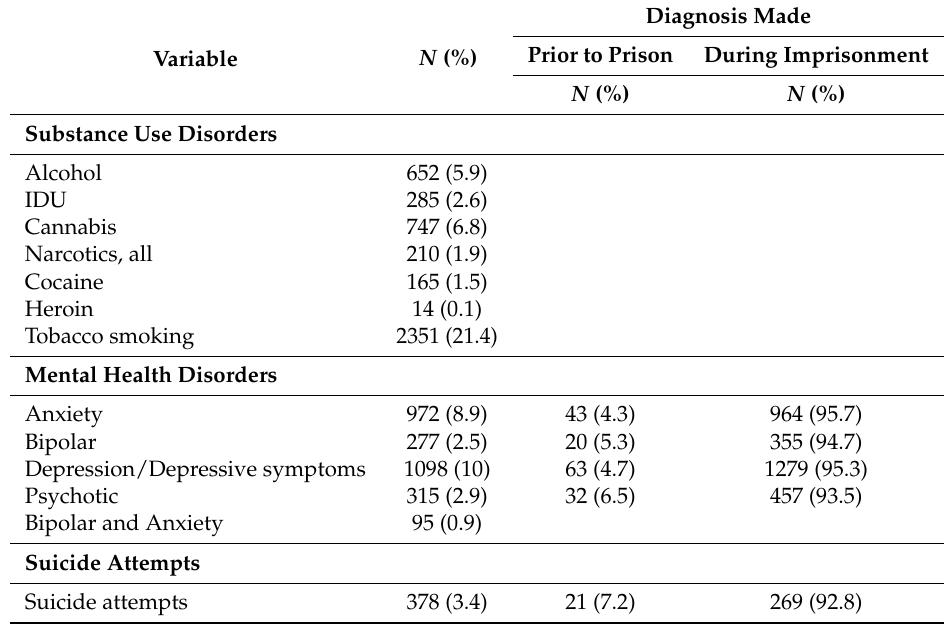
Table 3. History of substance use disorders, mental health disorders, and suicide attempt. Diagnosis Made Prior to Variable N (%)